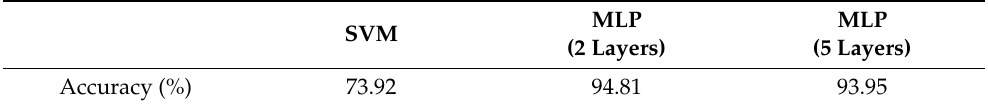
Table 9. The performance of the screening diagnostic tool using different